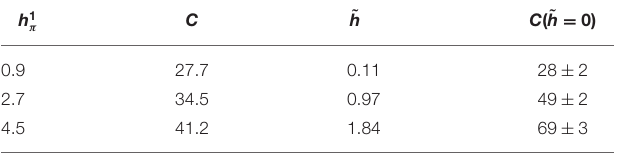
TABLE 6 | Values for C and ˜ h corresponding to different values of h 1 π (all LECs are given in units of 10 − 7 ) giving the minimum value of the χ 2 in the fit of the three p - p data experimental E